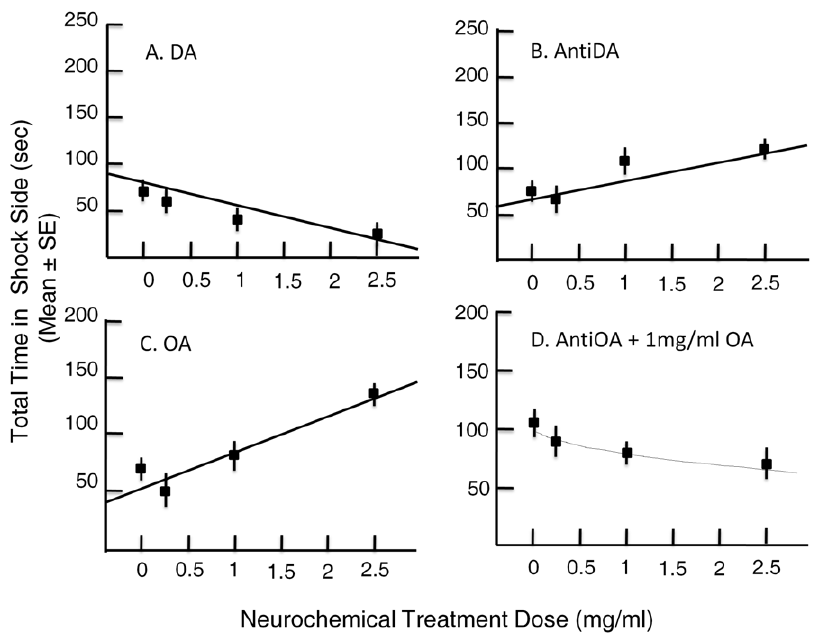
Figure 5. Dose responses for total punishment (shock) time during avoidance conditioning. A. DA dose response. A linear fit (y=78.152 2 23.226x; r=0.45; n=35, P , 0.01 where y=punishment time in sec. and x=dose in mg/ml) shows increasing dose of DA to lead to reduced punishment time during avoidance conditioning. B. Pimozide dose response. A linear fit (y=67.784 + 19.606x; r=0.39; n=43, P=0.01) shows increasing dose of Pimozide to lead to increased punishment time during avoidance conditioning. C. OA dose response. A linear fit (y=57.472 + 30.169x; r=0.52, n=40, P , 0.01) shows increasing dose of OA to lead to increased punishment time during avoidance conditioning. D. Mianserin dose response. In the case of mianserin, only the square root fit (y=102.167 2 23.172x 1/2 ; r=0.31, n=50, P , 0.05) was statistically